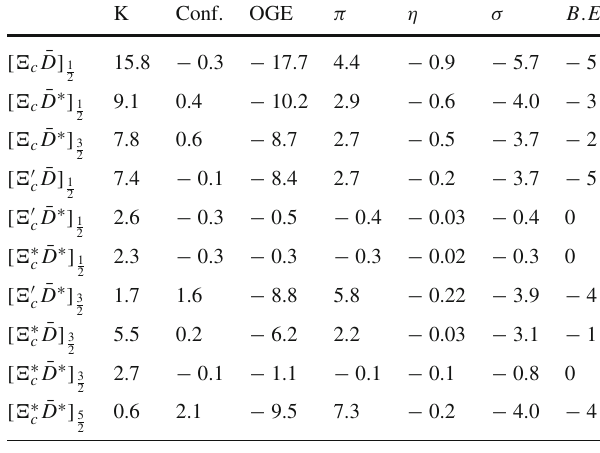
Table 6 Contributions of each term in Hamiltonian to the binding ( (cid:3) / ∗ ) energy for possible (cid:2) c